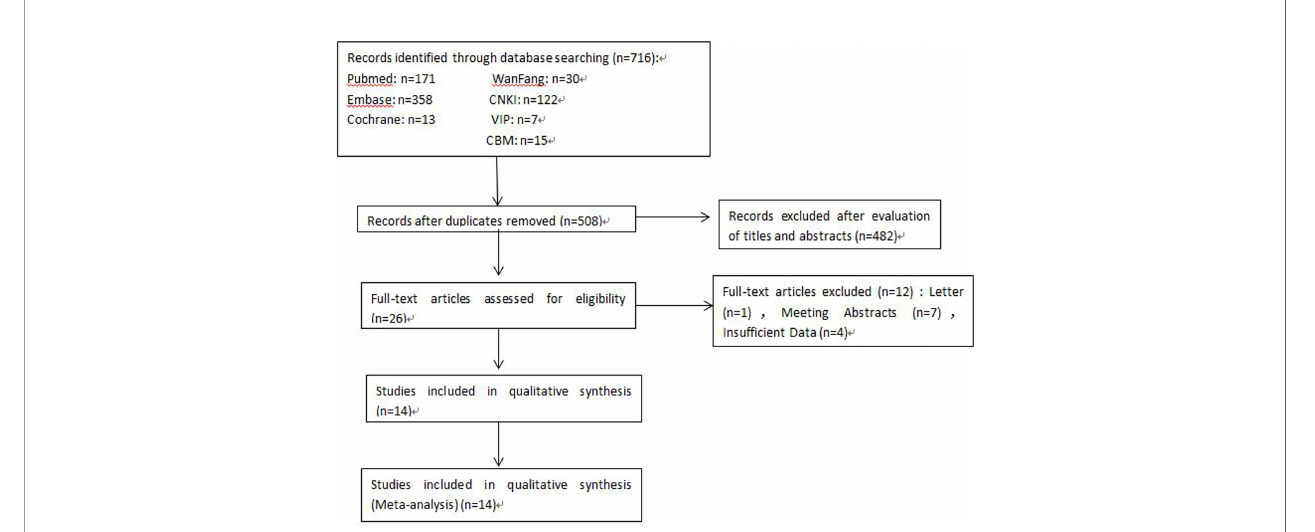
FIGURE 1 | Screening fl ow